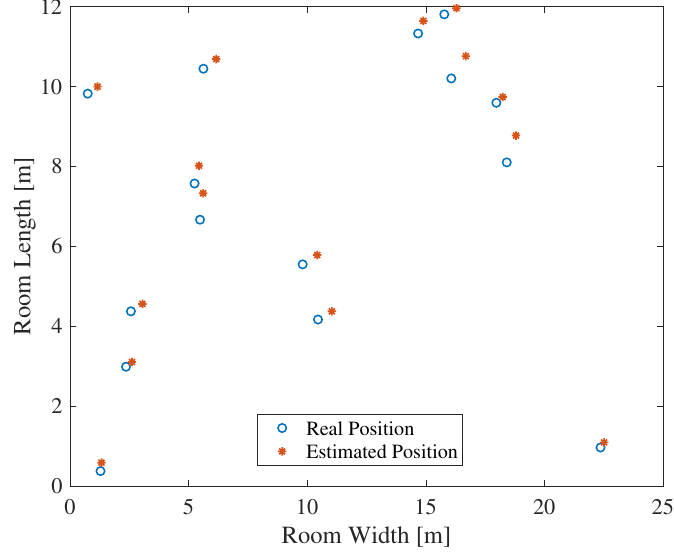
Figure 21. Estimated positions of the reader using deterministic channels, where the L-MIMO-RSSI algorithm is